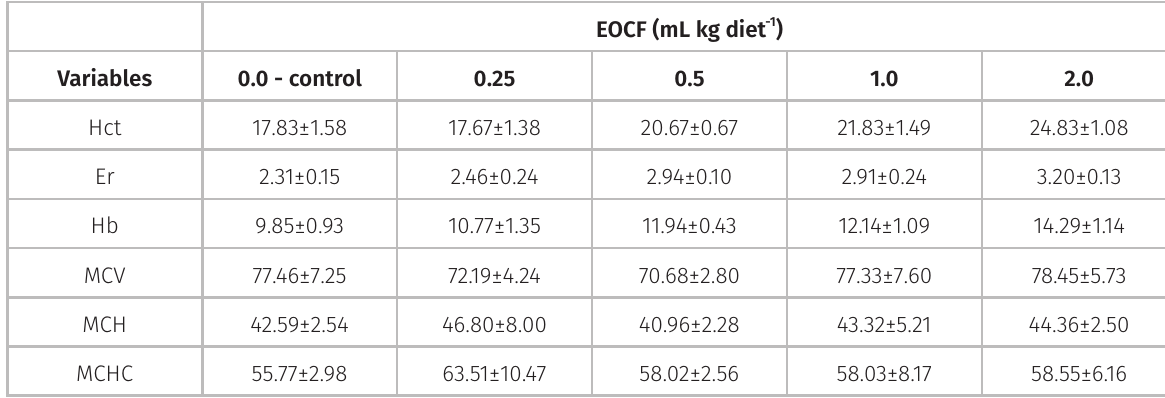
Table V. Hematological variables of Nile tilapia fed with diets containing different concentrations of the essential oil of Cymbopongon flexuosus